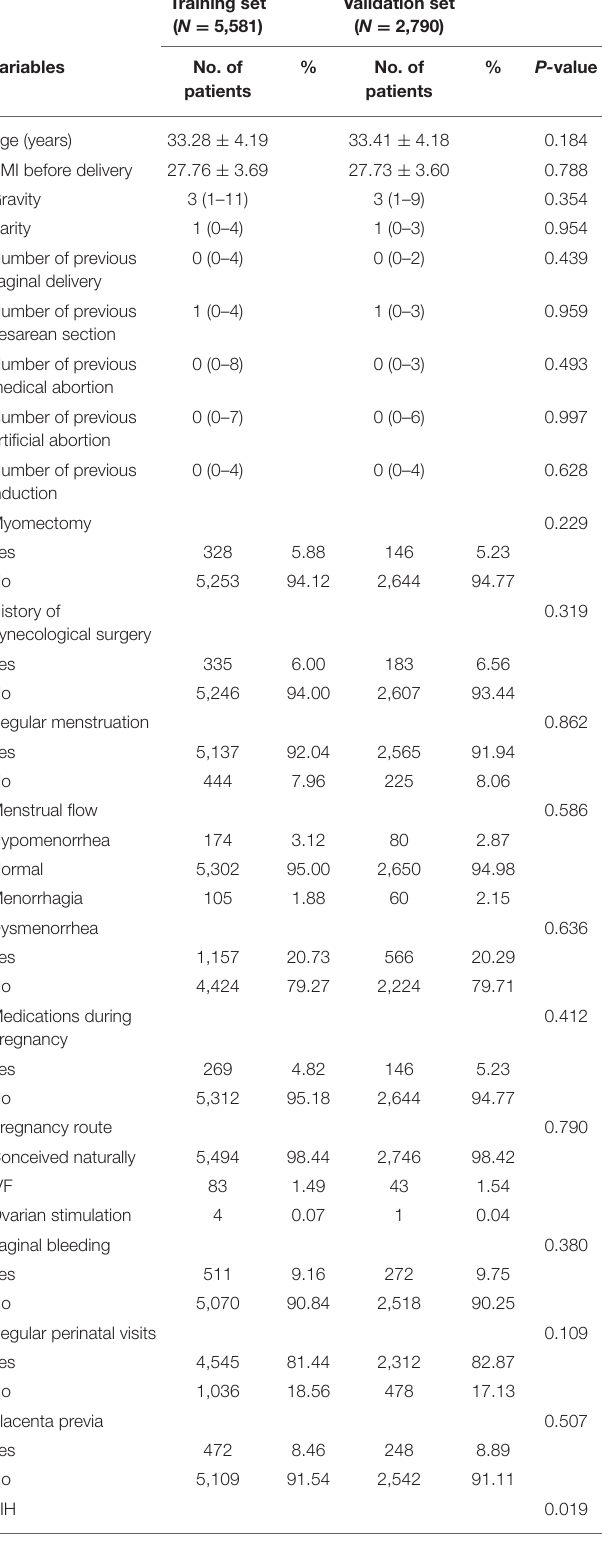
TABLE 1 | Characteristics of the study population. Training set ( N =